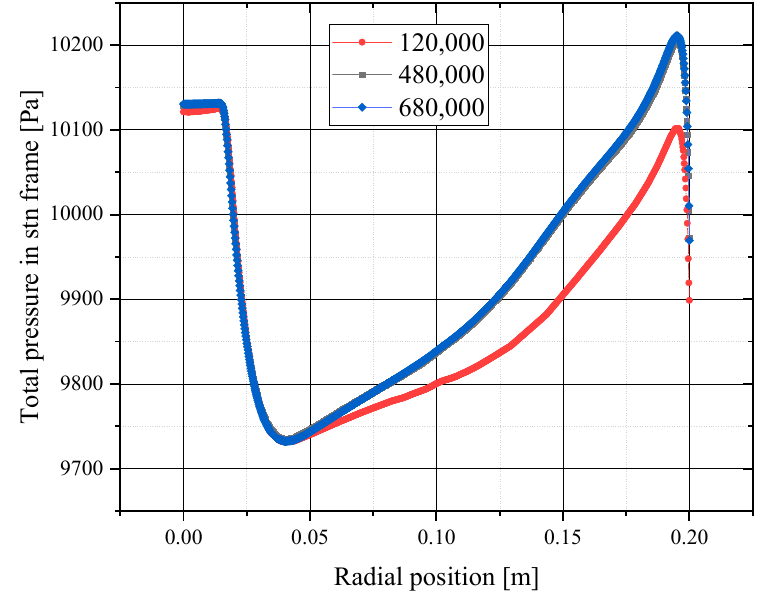
Figure 11. Verification of total pressure distribution.